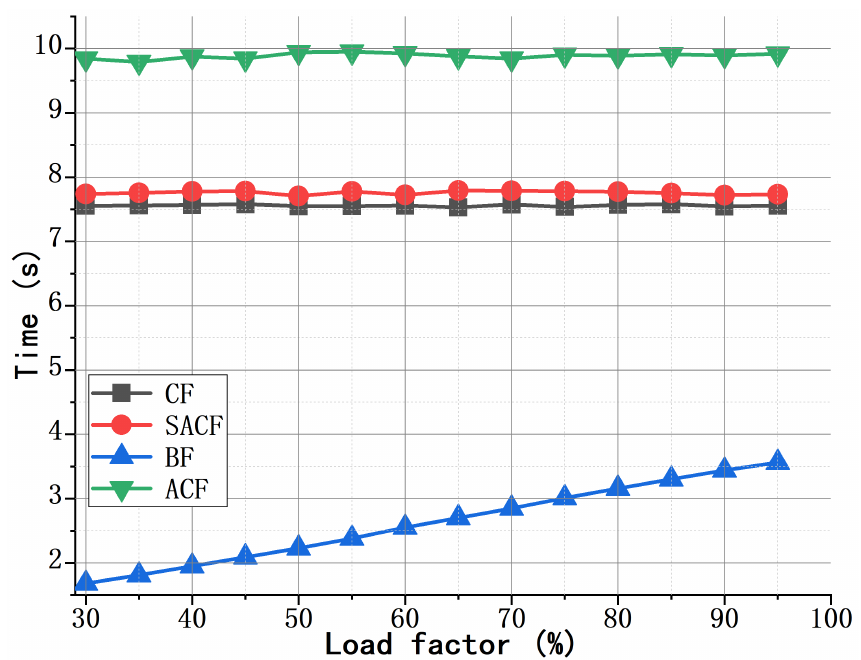
Figure 6. Times of 100 million negative queries at different load